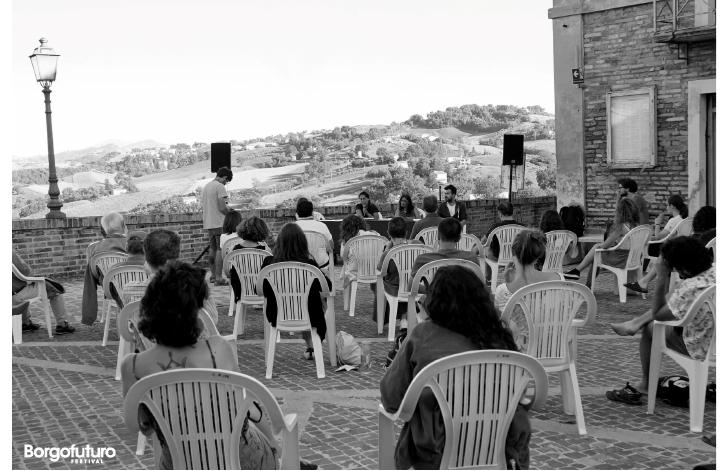
Figure 3. One of the “territorial roundtables” held in Colmurano (MC) in July 2020, organized within Borgofuturo Festival. Source: Vera Munzi.